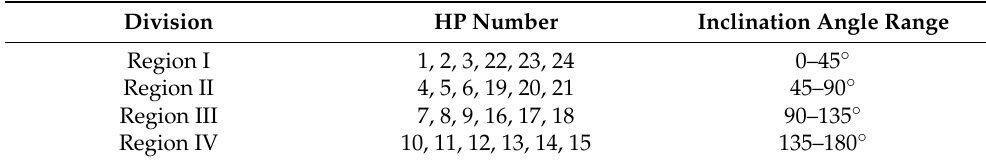
Figure 8. Numbering and partitioning of HPs in the specimen. Table 2. Partitioning of HPs in the